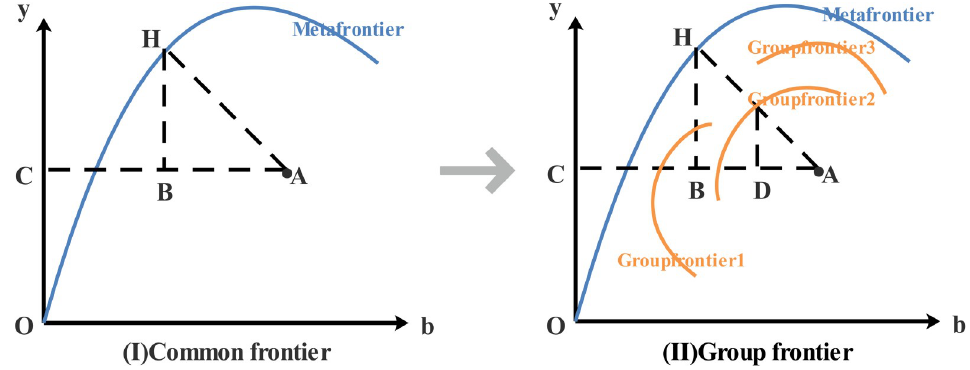
Fig 1. Common frontier and group